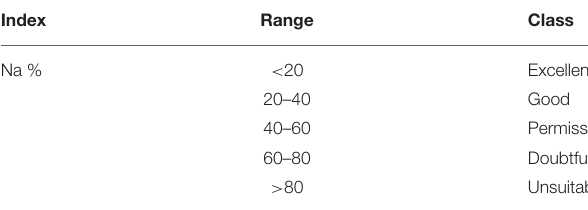
TABLE 1 | Classification of groundwater quality based on SAR. Index